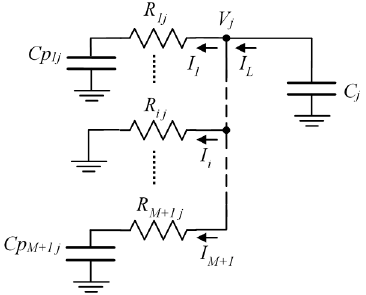
Figure 2. Detail of the j column of the circuit, showing the stray capacitors.